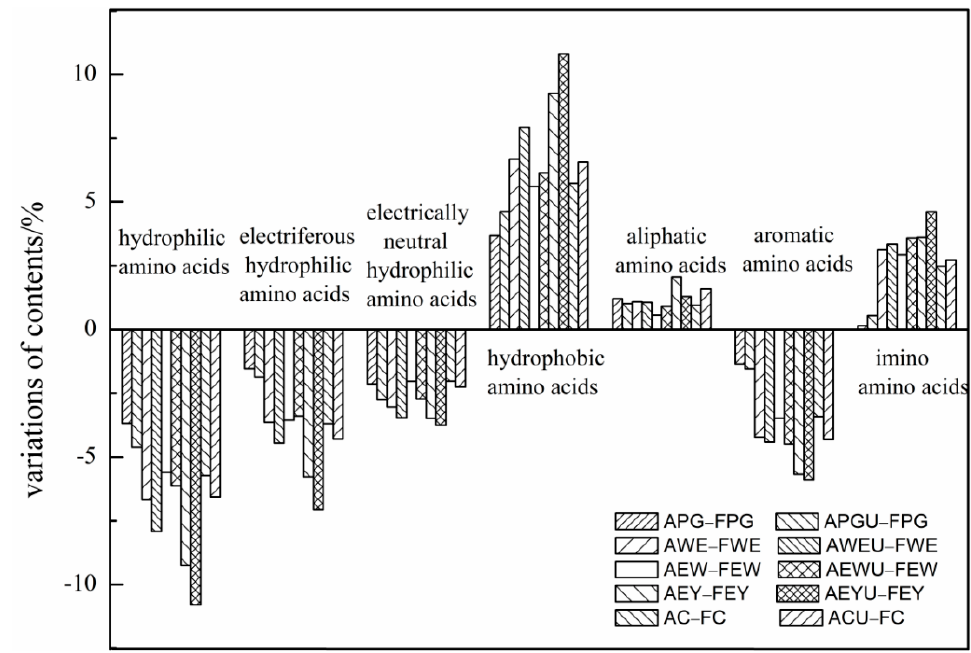
Figure 2. The content fluctuations of the seven groups of amino acids in the five fresh and aged binders.